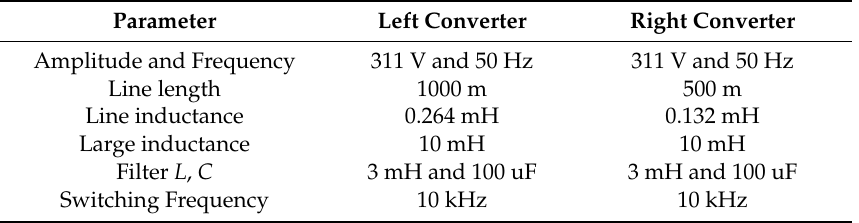
Table 2. System simulation